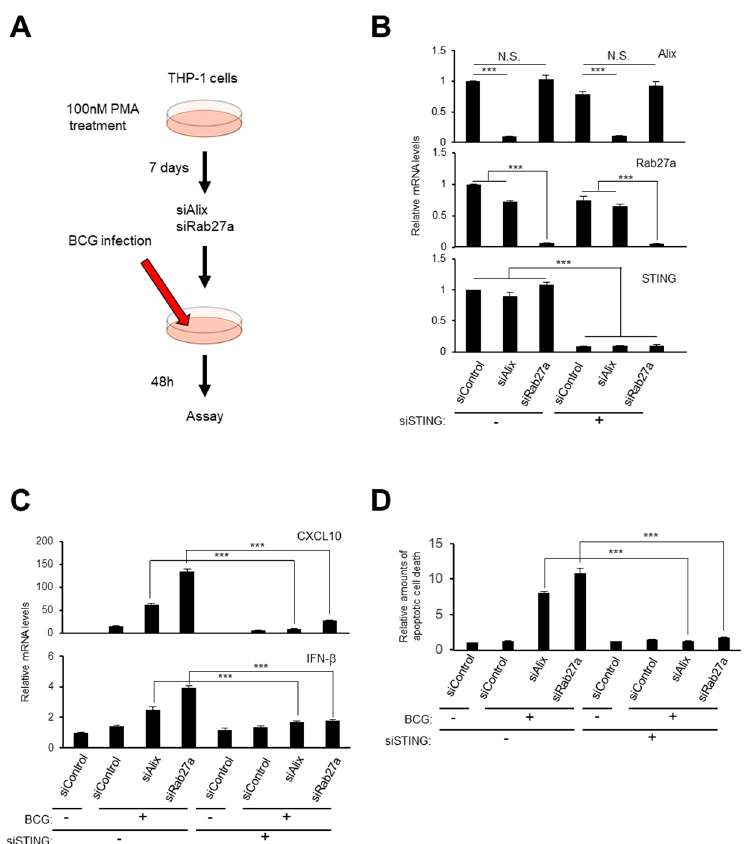
Figure 5. The release of small EVs blocks the inflammatory response caused by bacterial infection. ( A ) Timeline of the experimental procedure. ( B–D ) THP-1 cells were treated with 100 nM PMA for 7 days and transfected with indicated siRNA oligos. After incubation with Bacillus Calmette-Guérin (BCG), RT-qPCR analysis was performed for confirmation of knockdown efficiency ( B ) or innate immune responsible gene expression ( C ). The amounts of apoptotic cell death was quantitatively measured ( D ). For all graphs, error bars indicate mean + standard deviation (s.d.) of triplicate measurements. p values was calculated by unpaired two-tailed Student’s t -test (*** p < 0.001, N.S. (not significant)).